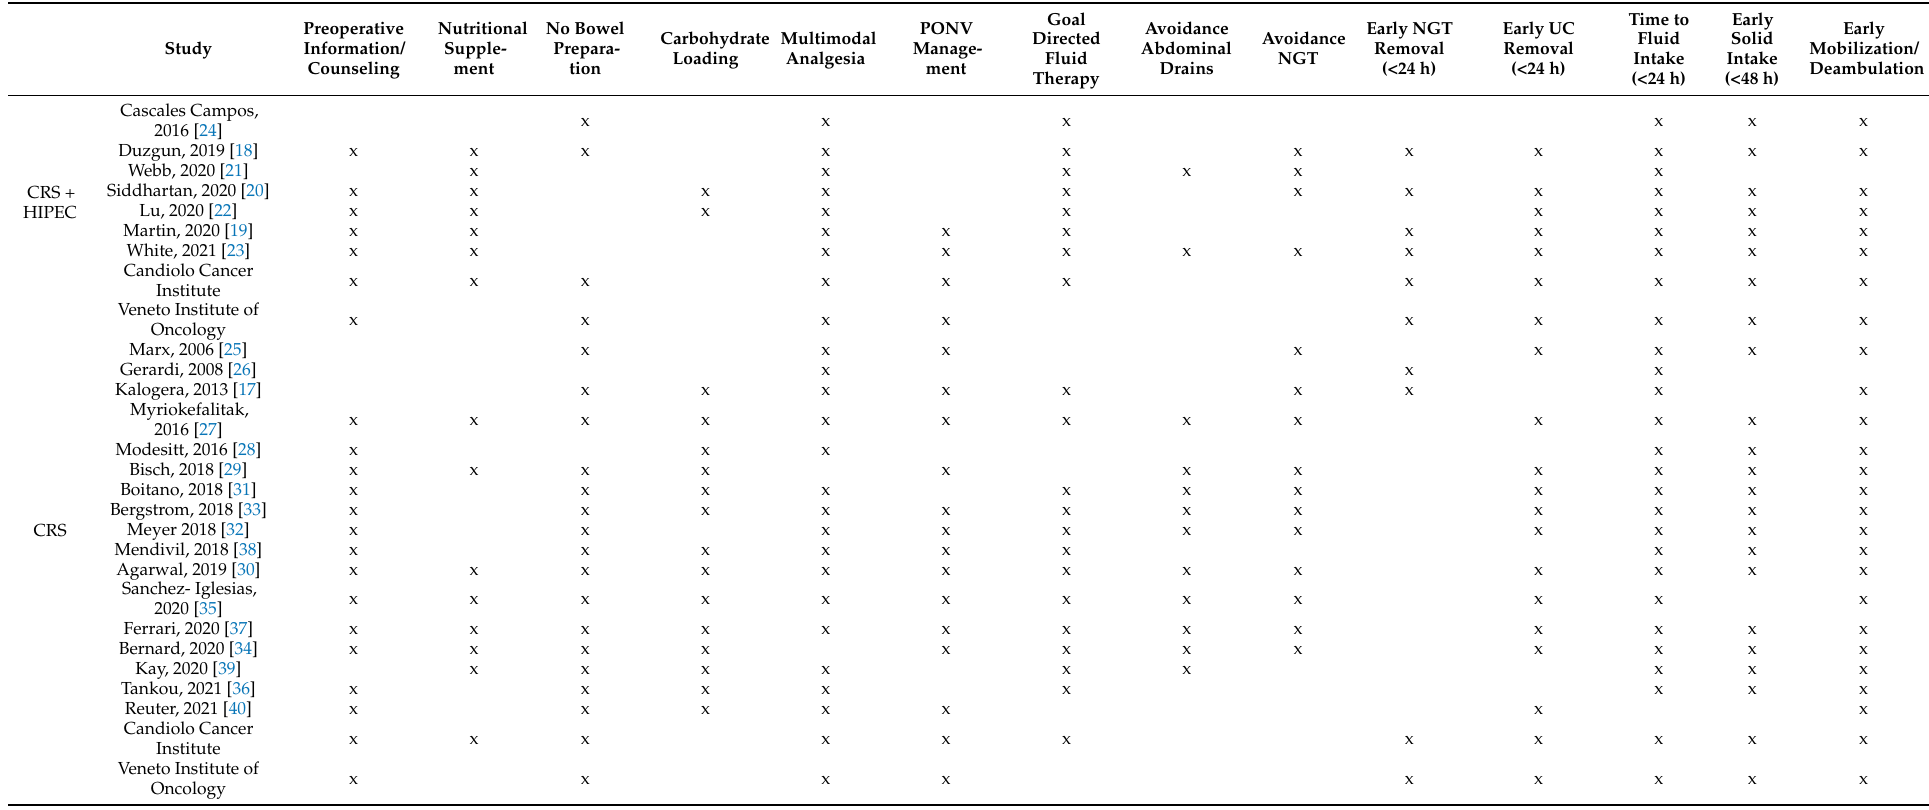
Table 5. ERAS elements in the included